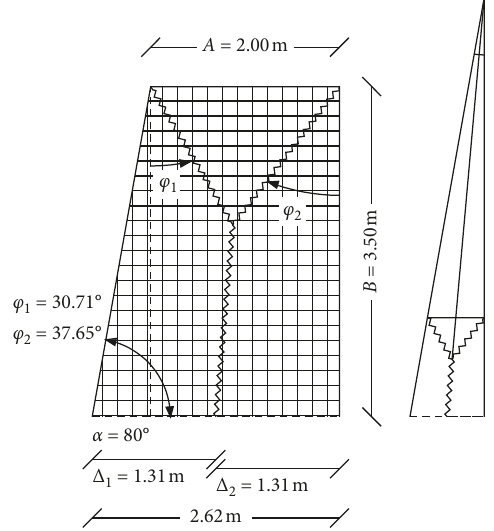
Figure 7: Failure mechanism with an inner triangular slab region and two lateral trapezoidal ones having a side in common inter- secting the free